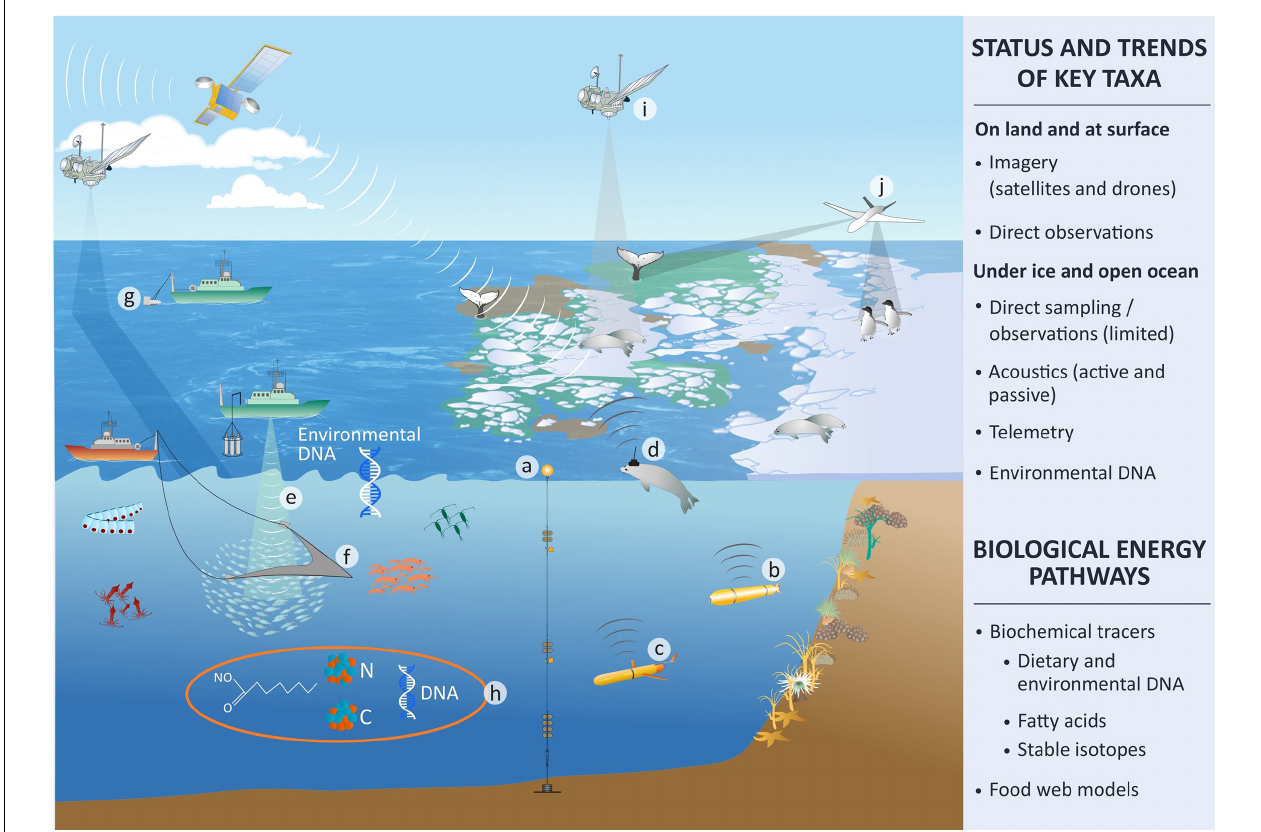
FIGURE 11 | Schematic illustration of the observation and models required to resolve key uncertainties regarding the impacts of global change on Southern Ocean ecosystems (adapted from Meredith et al., 2013). Mid-water taxa and food webs (particularly under seasonal ice and during the winter) are a key gap. Observations from platforms such as moorings (a) , AUVs (b) , gliders (c) , and animal-borne instruments (d) , along with improvements in acoustics (e) (including acoustic observation models) will help resolve status and trends of taxa, complementing traditional methods such as net sampling (f) and CPR (g) . Integration of biochemical tracer data (such as dietary and environmental DNA, fatty acids, stable isotopes, h ) and observations into food web models will be required to constrain biological energy pathways. Imagery from satellites (i) and drones (j) will greatly improve knowledge of marine mammals, penguins, and other seabirds in difficult to observe areas such as pack